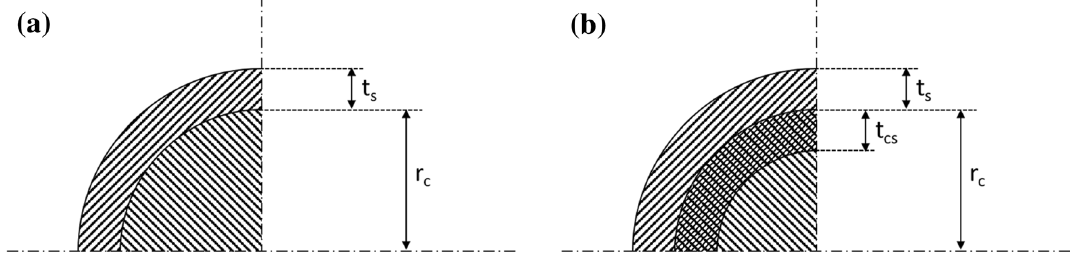
Fig. 5 Scheme of the geometric model used for the calculation of the shell thickness from specific surface data ( a ) and from density data ( b